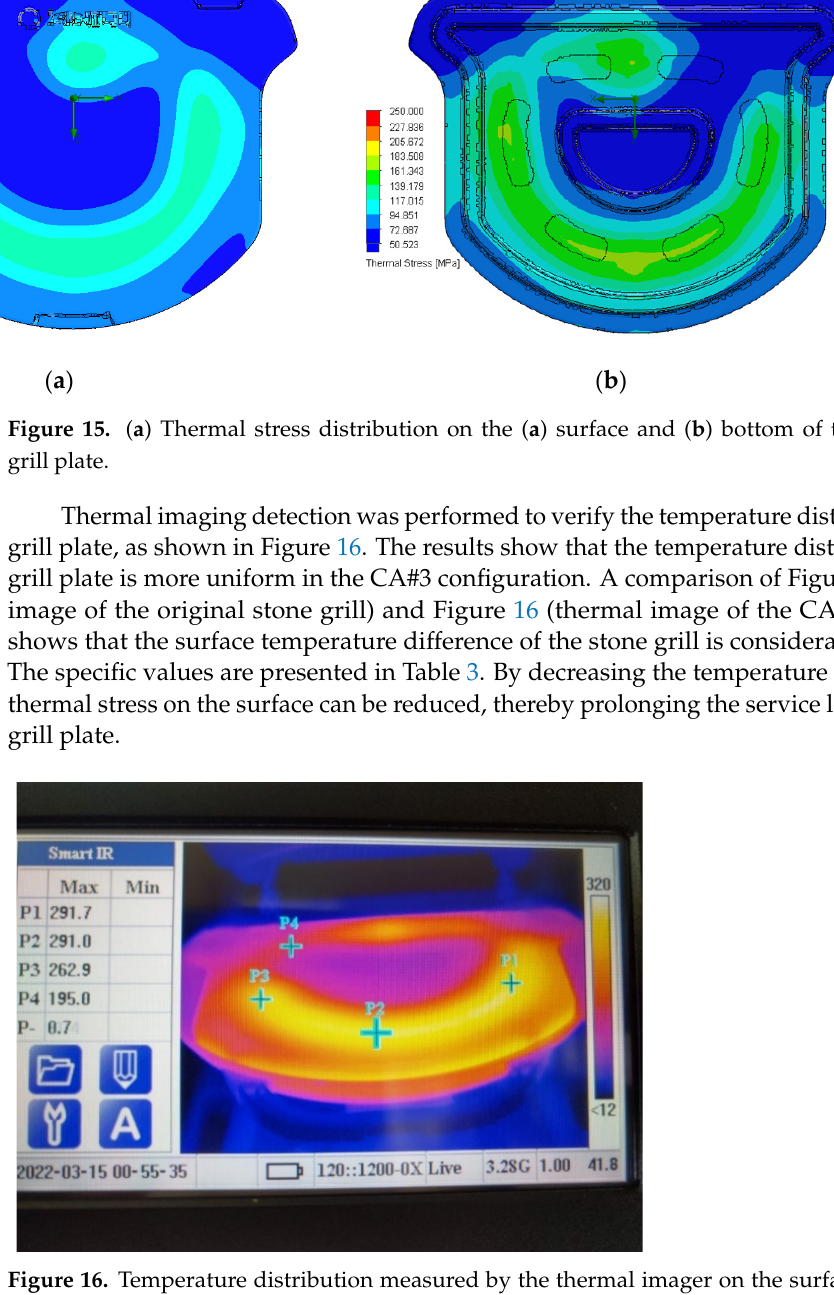
( b ) Figure 14. Temperature distribution on the ( a ) surface and ( b ) bottom of the CA#3 stone grill plate. Figure 15 shows that the areas with high thermal stress on the surface of the stone grill appear at the relative positions of the combustion tubes. The maximum thermal stress is approximately 117–139 MPa. In addition, the high thermal stress at the bottom of the